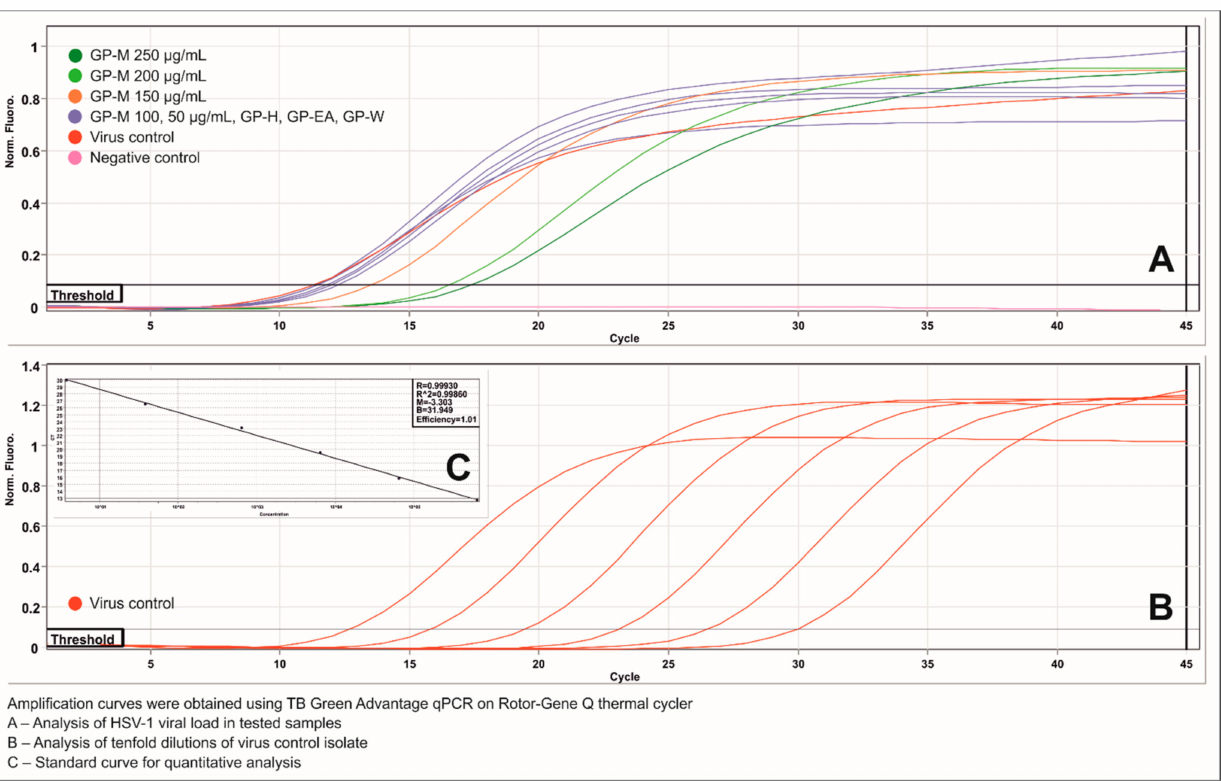
Figure 4. Real-Time PCR analysis of HSV-1 viral load in tested